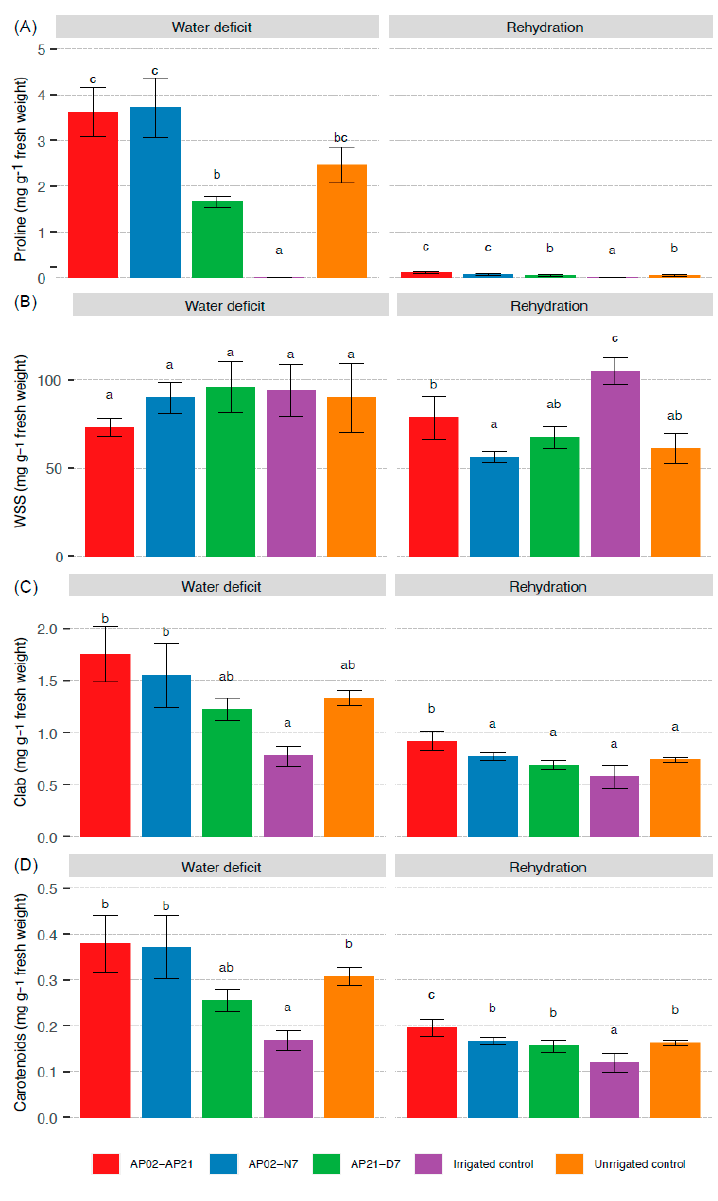
Figure 3. Biochemical parameters of perennial ryegrass after 10 days without irrigation and 3 days after rehydration on proline content ( A ), water-soluble sugars (WSS) ( B ), chlorophyll (Clab) a and b ( C ), and carotenoids ( D ). Each value represents the mean of the replicates from the two independent experiments ± SE. Different letters indicate statistically significant differences observed according to Fisher’s LSD test with Bonferroni correction ( p < 0.05).